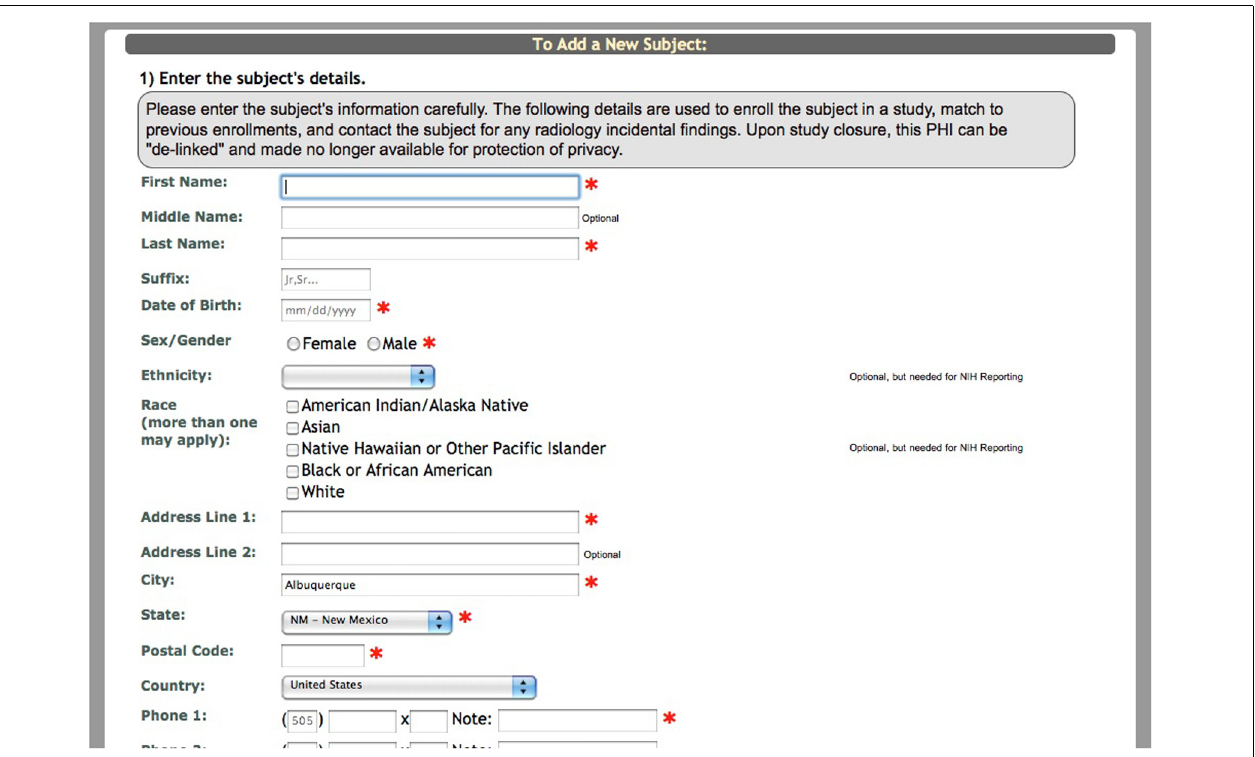
FIGURE 2 | Add a new